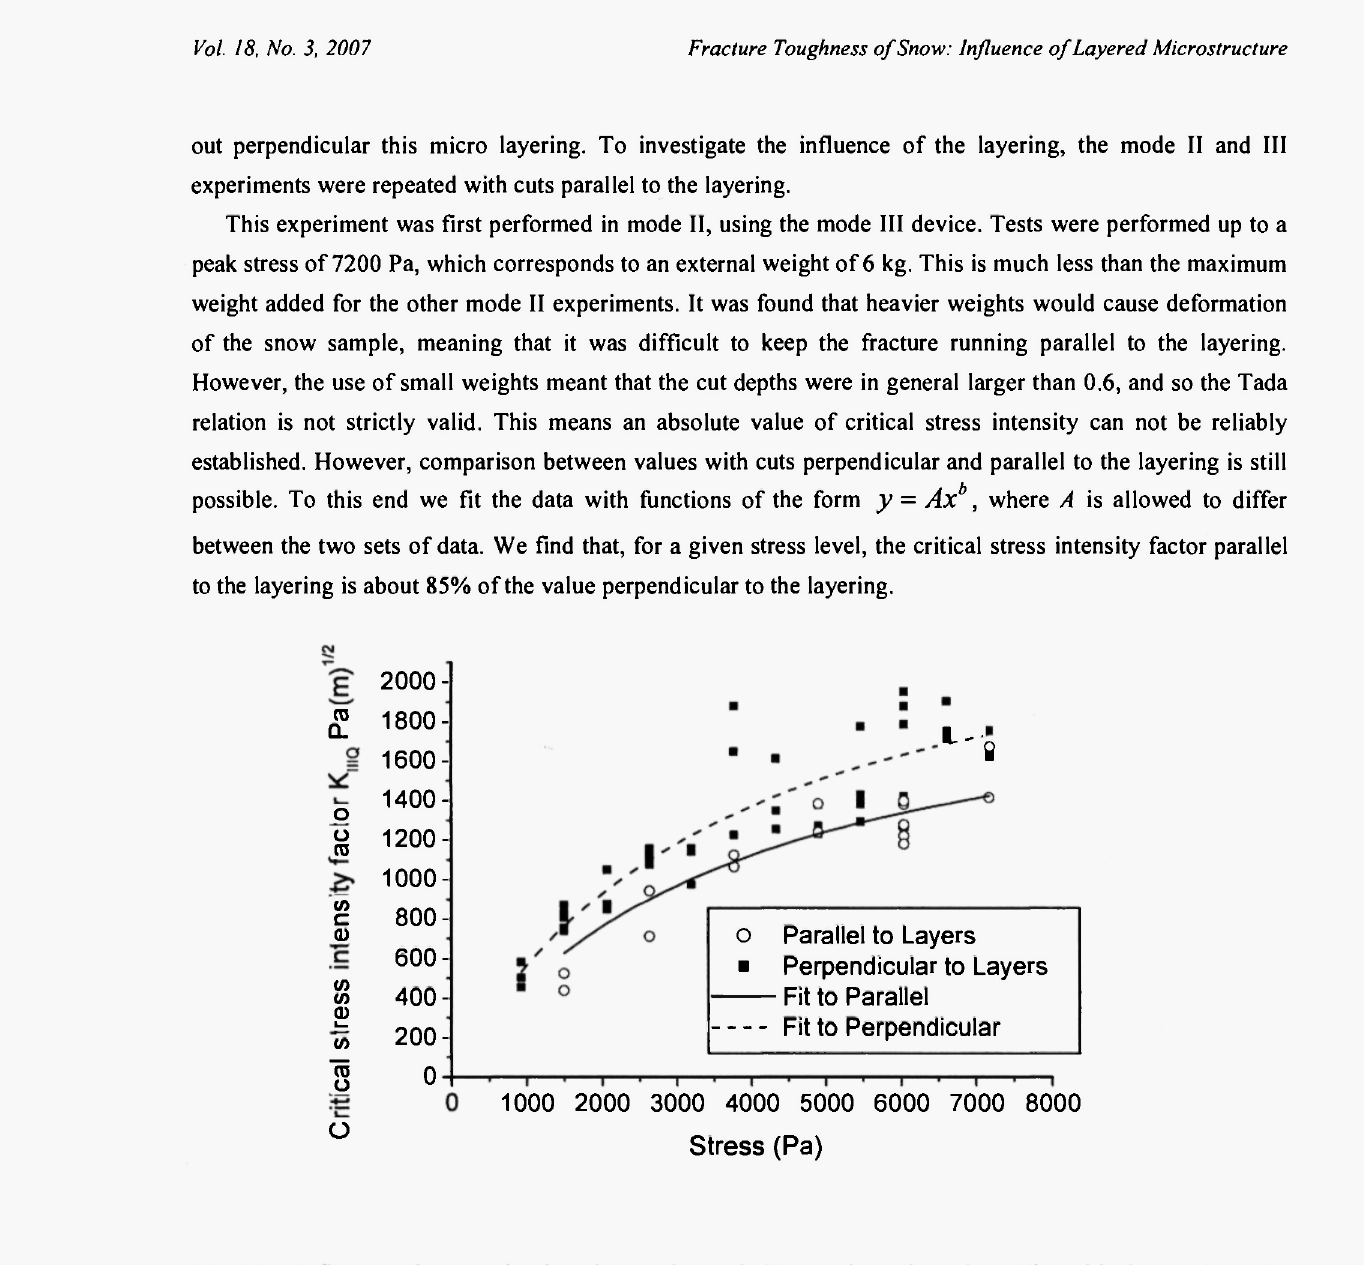
Fig. 16: Influence of snow microlayering on the mode II stress intensity values. The critical stress intensity for cracks parallel to the microlayering is found to be approximately 85% of that perpendicular to the